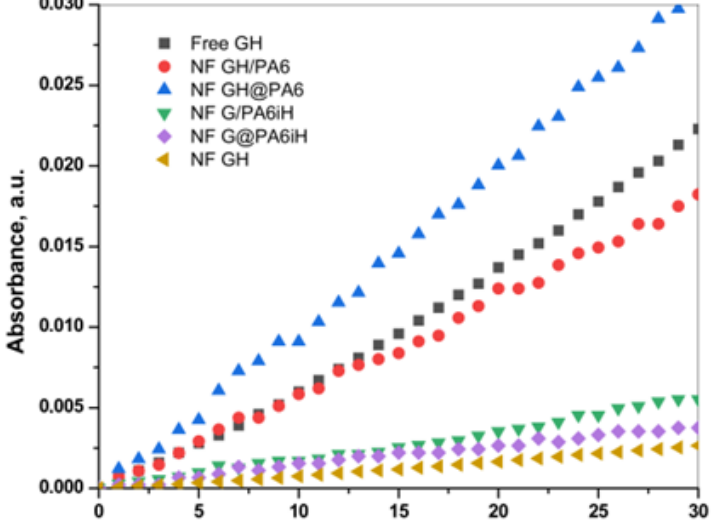
Figure 9. Overall catalytic activity of PANF complexes in comparison to the free GOx/HRP dyad (free GH) and the same incorporated in NF without PA6 MP (NF GH). For more details, see the text. Table 1. Activity parameters of the bienzyme PANF complexes compared to the free GOx/HRP enzymes and to bienzyme standard NF without PA6 MP. Assay conditions: GOx/HRP